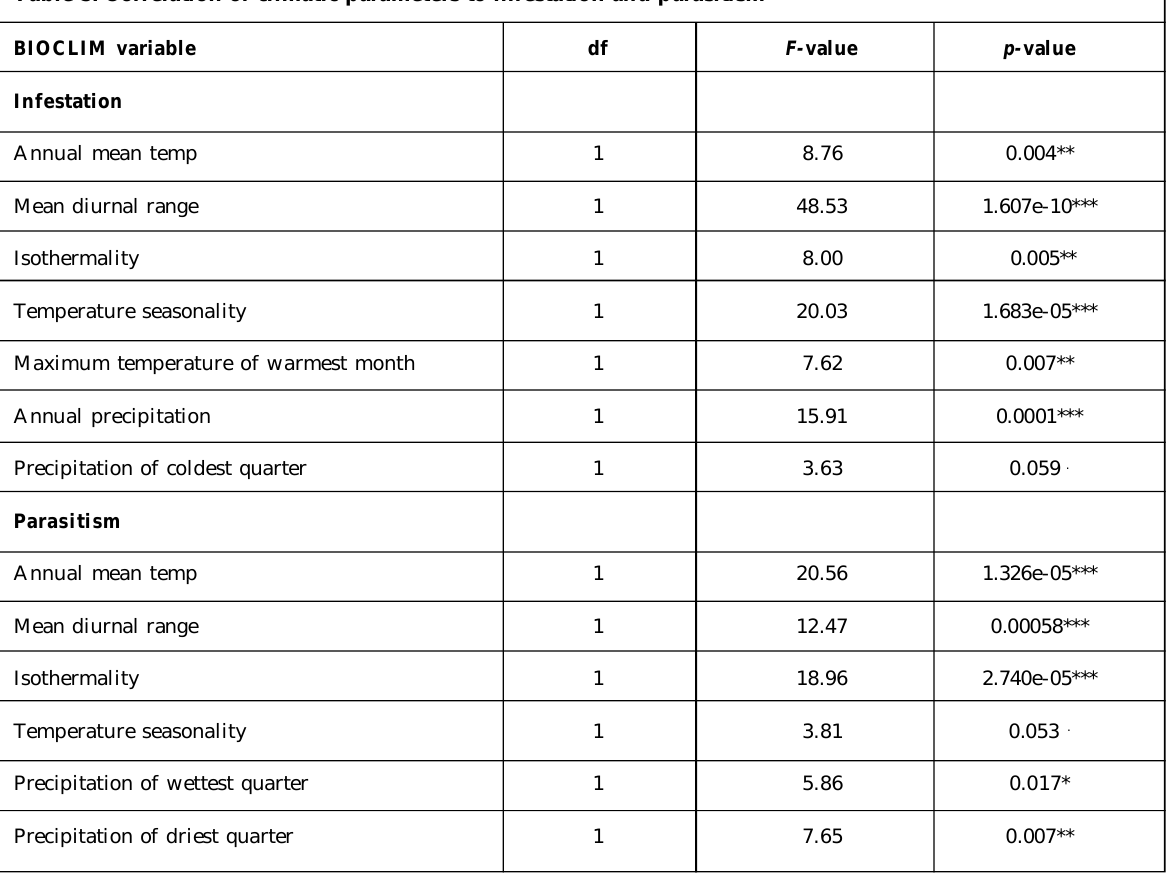
Table 5: Correlation of climatic parameters to infestation and parasitism BIOCLIM